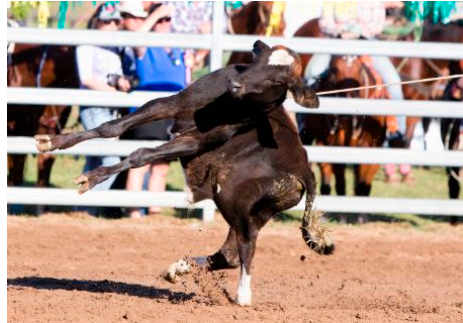
Figure 1. Typical ‘chase’ image within one second of being released from the chute.